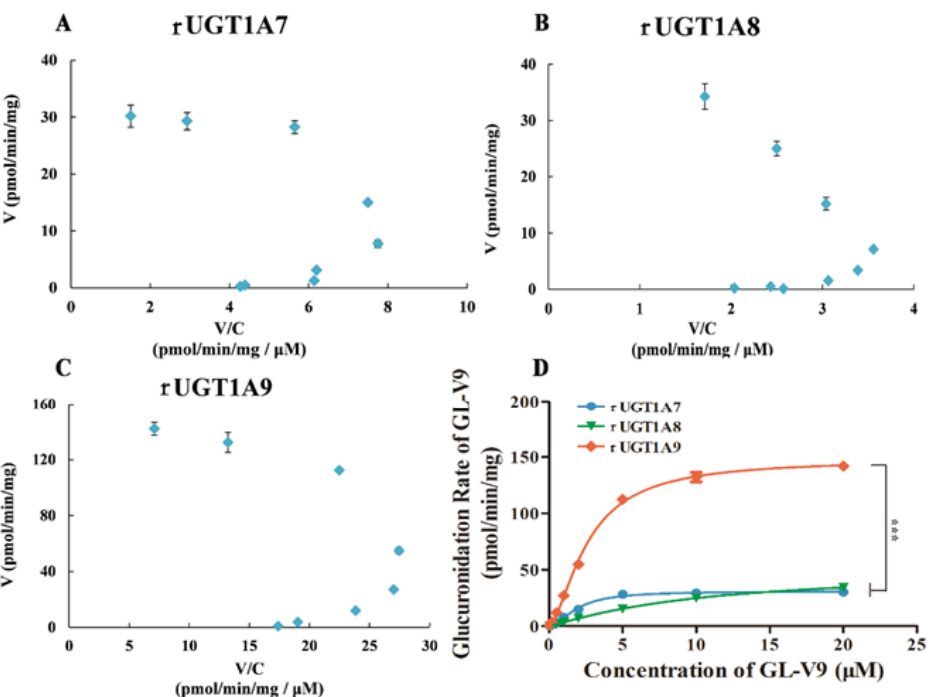
Figure 6. Eadie-Hofstee plots for the formation of 5-O-glucuronide GL-V9 by rUGT1A7 ( A ), rUGT1A8 ( B ), rUGT1A9 ( C ) and enzyme kinetics comparisons between these isoenzymes ( D ). Serial concentrations of GL-V9 were incubated with rUGT1A7, 1A8 or 1A9 for 1 h at 37 °C. Glucuronides of GL-V9 in incubation system were quantified using UPLC-MS/MS. The formation rates were calculated and described as pmol/min/mg protein. Kinetic profiles were fitted into Eadie-Hofstee plots and Michaelis-Menten plot to determine enzyme-mediated reaction types. All the data were expressed as the average of three determinations and the error bar represents the standard deviation of the mean (mean ± SD, n = 3). *** p < 0.001 indicating significantly different.